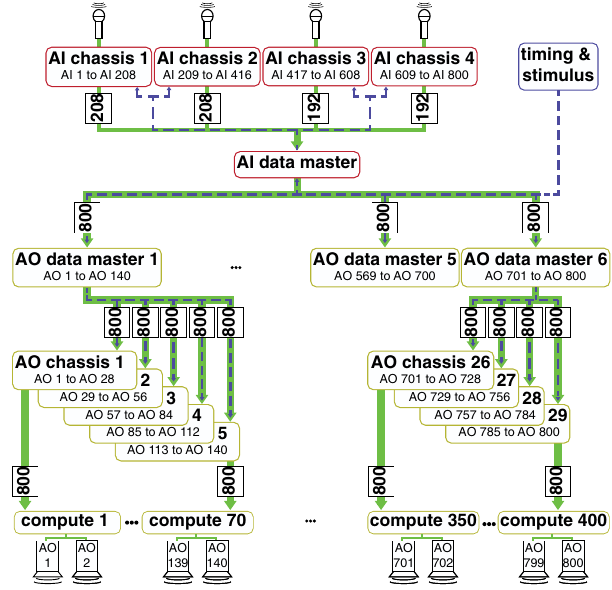
FIG. 9. High-level view of the WaveLab system architecture. From top to bottom: The input data of 800 channels are collected over four analog input (AI) chassis and aggregated on the AI data master. The full input data set is distributed to six analog output (AO) data masters, which further pass the data set to 29 analog output chassis. Each AO chassis consists of up to 14 compute nodes, each capable of computing the output for two sources. The start of an experiment is triggered and synchronized by a central timing and stimulus chassis (blue dashed